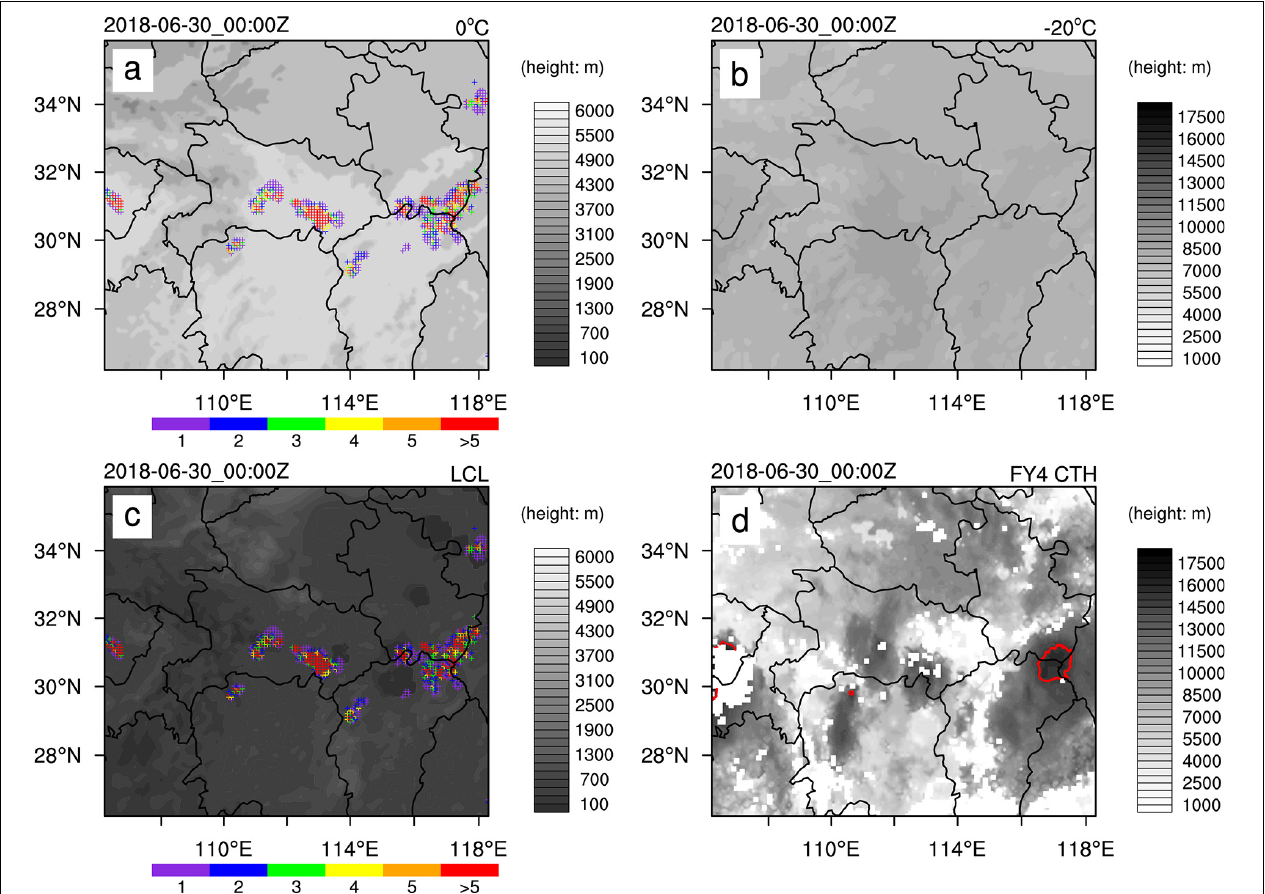
FIGURE 6 | The heights of 0 ◦ C (a) and − 20 ◦ C (b) in the background field, LCL (c) and FY4 CTH (d) (gray-shaded) at 0000 UTC on 30 June 2018. The color marker (in a,c ) indicate the frequency of lightning occurrence within 1 h of FY4. The red contours (in d ) are for the FY4 CTH 15 km